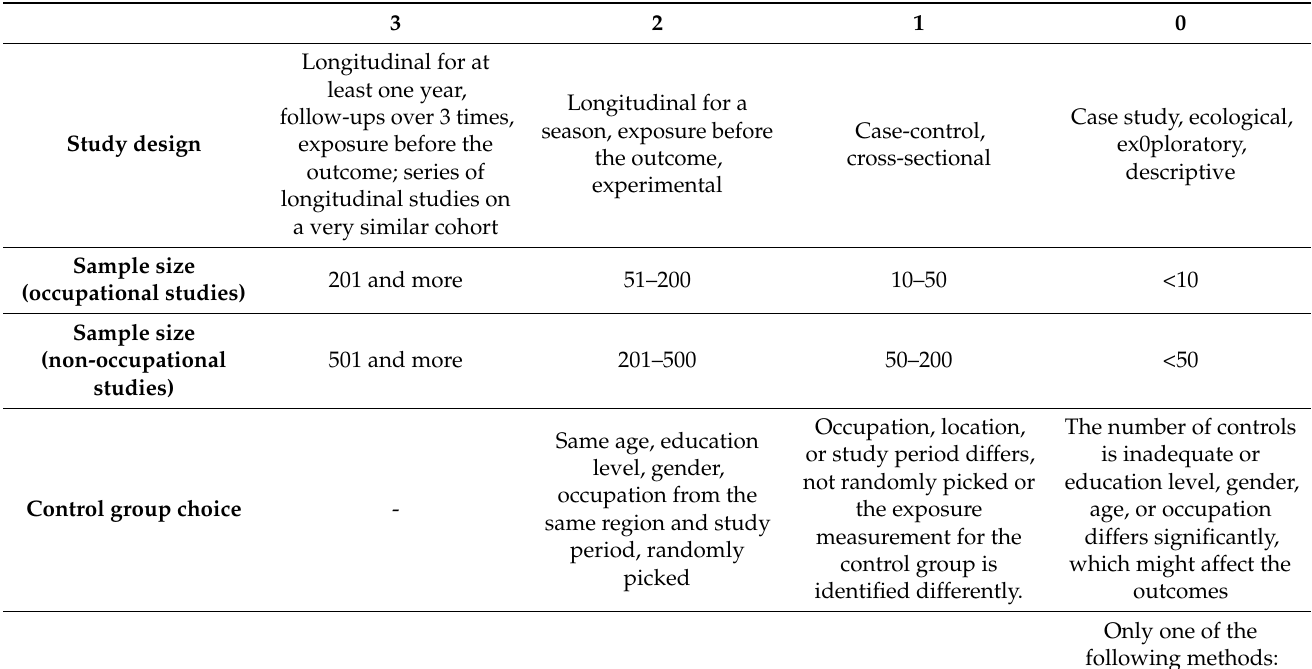
Table 2. The scoring system for the ranking of the